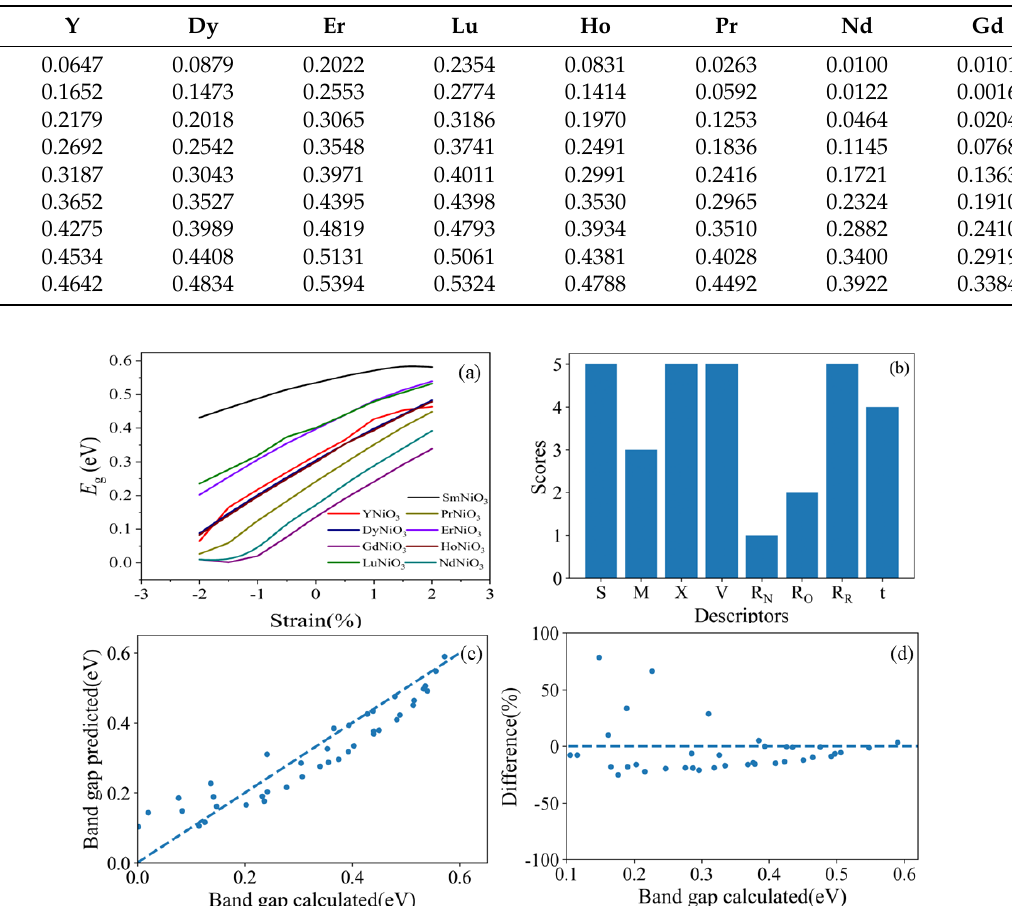
Table 1. Band gaps of RE NiO 3 ( RE = Sm, Y, Pr, Ho, Dy, Er, Lu, Nd, Gd) under different planar strains.